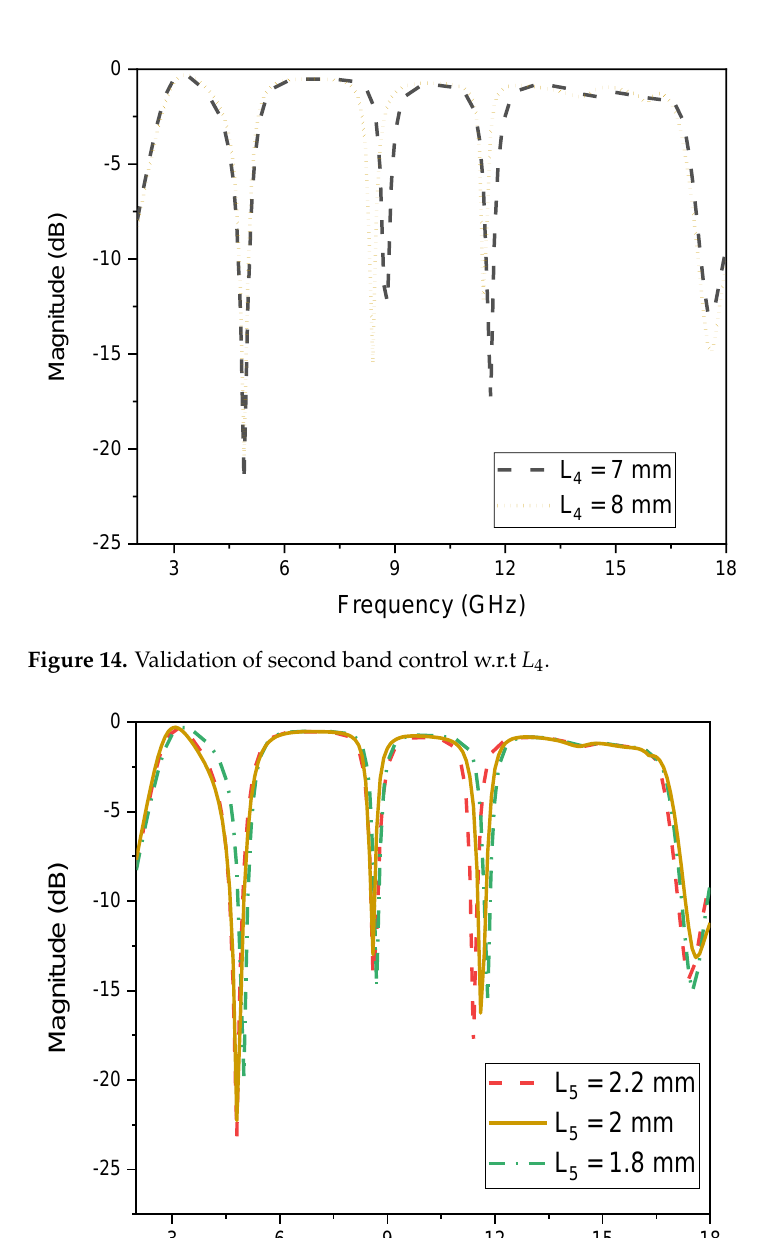
Figure 13. Validation of first band control w.r.t .